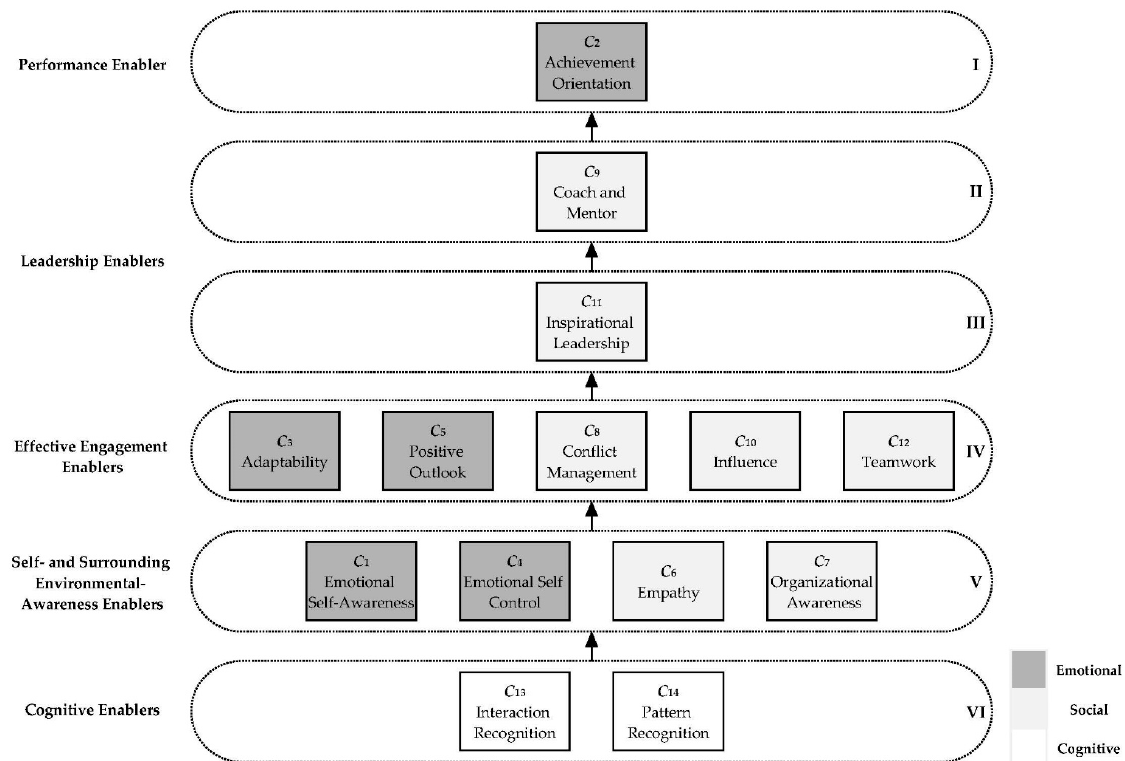
Figure 3. Final Interpretive Structural Modeling (ISM) diagram of critical Systems-Thinking-based leadership competencies as enablers to better construction safety